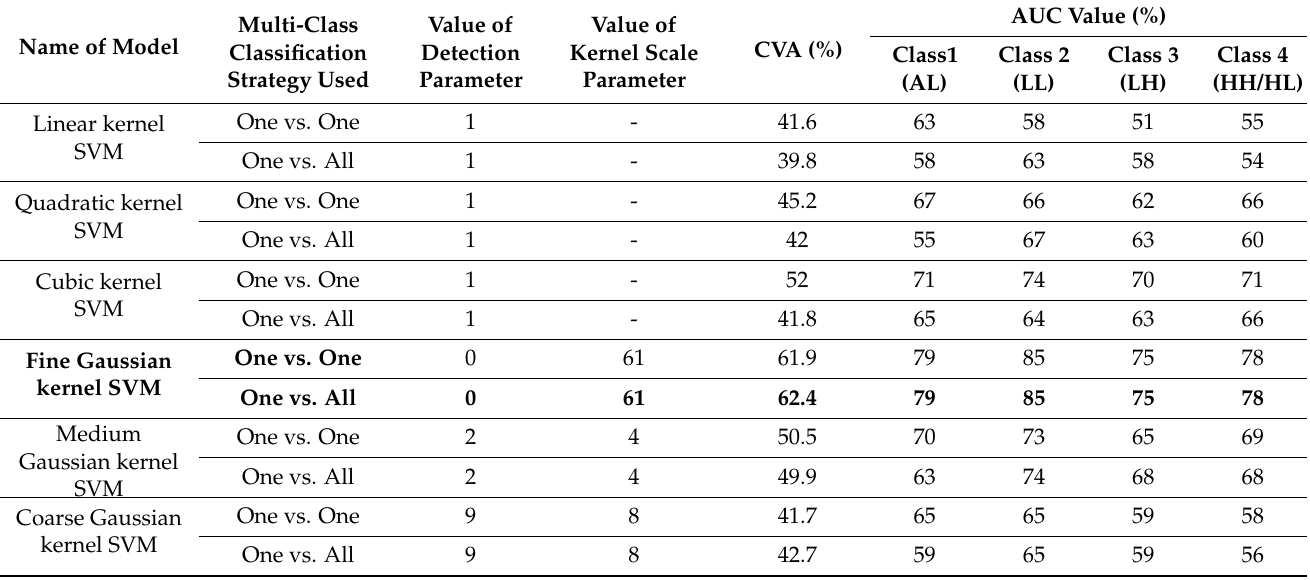
Table 5. Results of the automatic classifications with SVMs. The best performing model that was selected for the SVM category is shown in bold type.